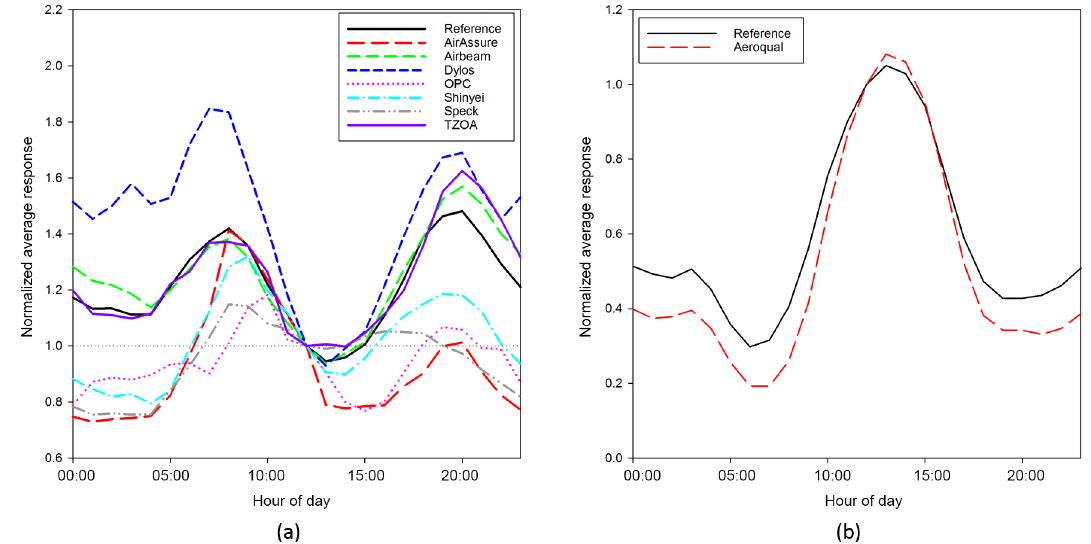
Figure 4. Diel patterns for (a) PM 2 . 5 and (b) O 3 sensor and reference measurements.